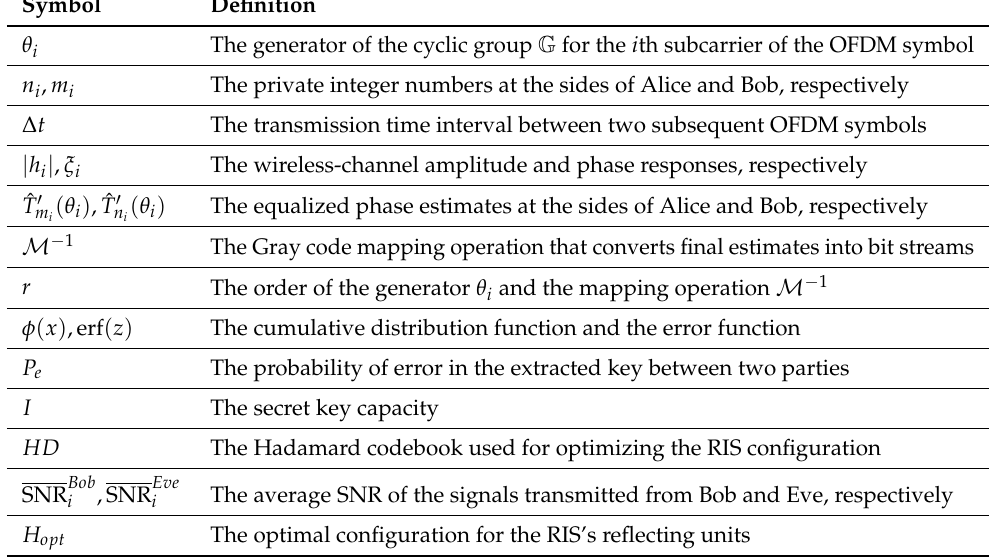
Table 1. List of